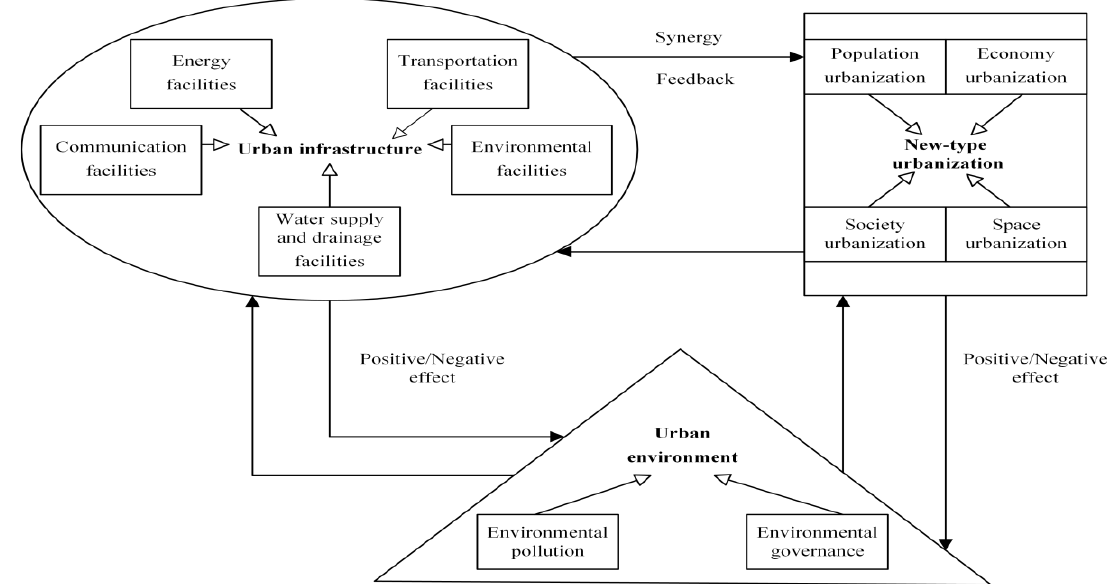
Figure 3. Relationship network of new-type urbanization, urban infrastructure and urban environ- ment (NTU-UI-UE).